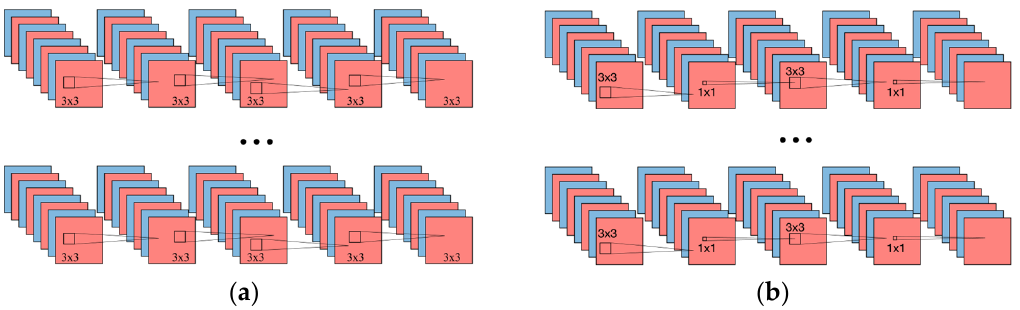
Figure 3. The structure of the convolution filter for ( a ) Standard convolution; ( b ) Heterogeneous convolution.